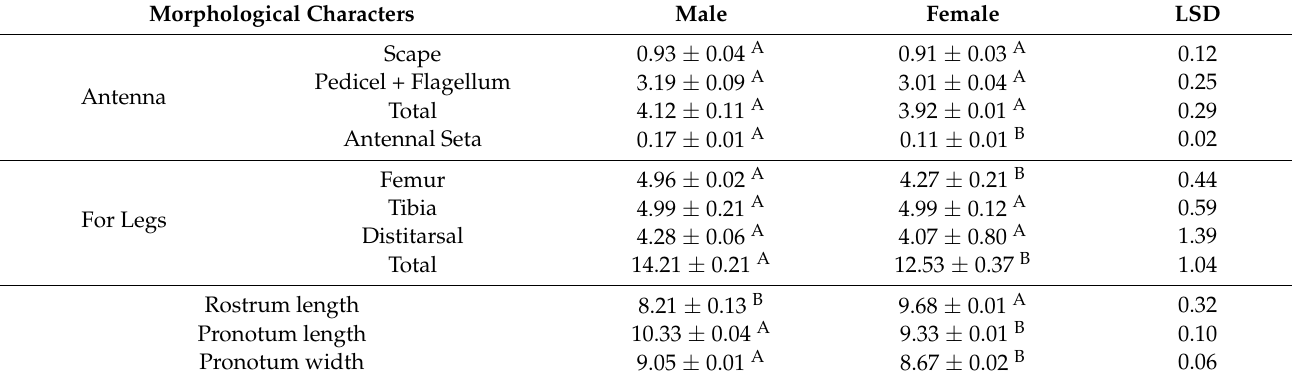
Table 2. Measurements (mm) of some morphological characteristics between RPW males and females collected during 2019 (note: p > 0.05, n = 13 random individuals). A and B: no statistically significant difference ( p > 0.05) between any two means for the same attribute within the same row with the same capital letter